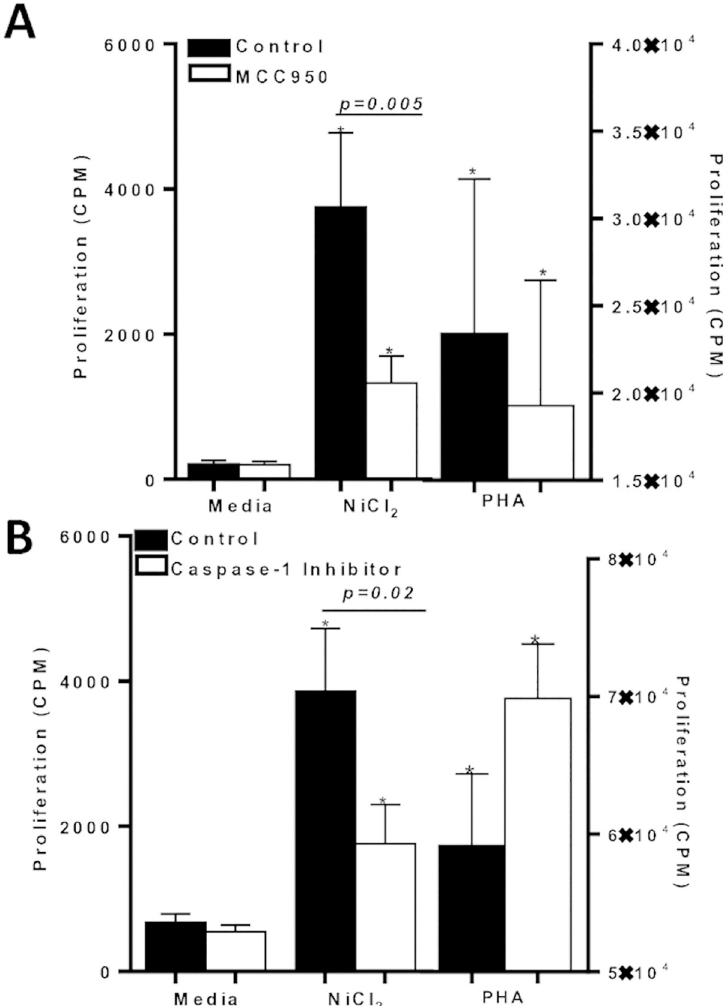
Fig 9. Metal-reactive lymphocytes from individuals’ exhibit significant decreased metal-reactivity in the presence of inflammasome based inhibitors. Proliferation of human lymphocytes was measured by 3 H-thymidine incorporation after 6 d of in vitro metal-challenge and in the presence of either a: (A) NLRP3 inflammasome inhibitor (MCC950) from n = 5 individuals or (B) Caspase-1 inhibitor from n = 5 individuals. Data are shown as mean ± SEM. Asterisk ( � ) signifies statistical significance at p � 0.05 compared to respective control group as determined by paired Student’s